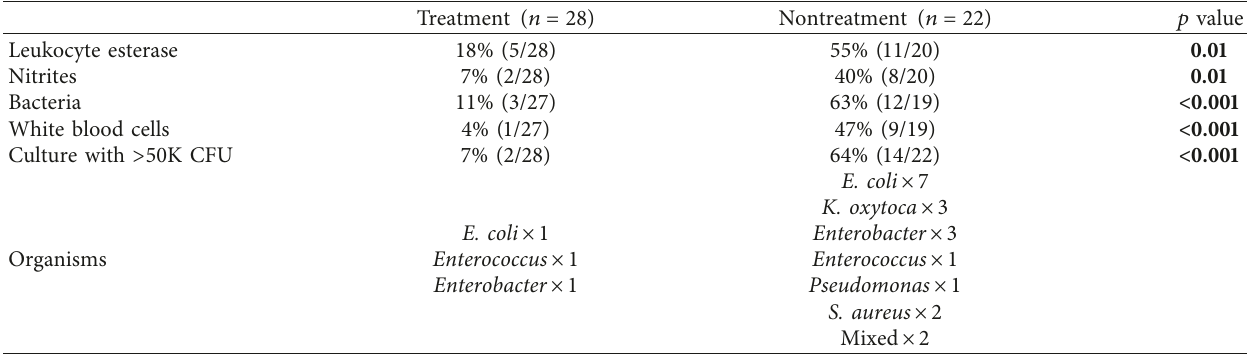
Table 2: Postoperative urine characteristics.